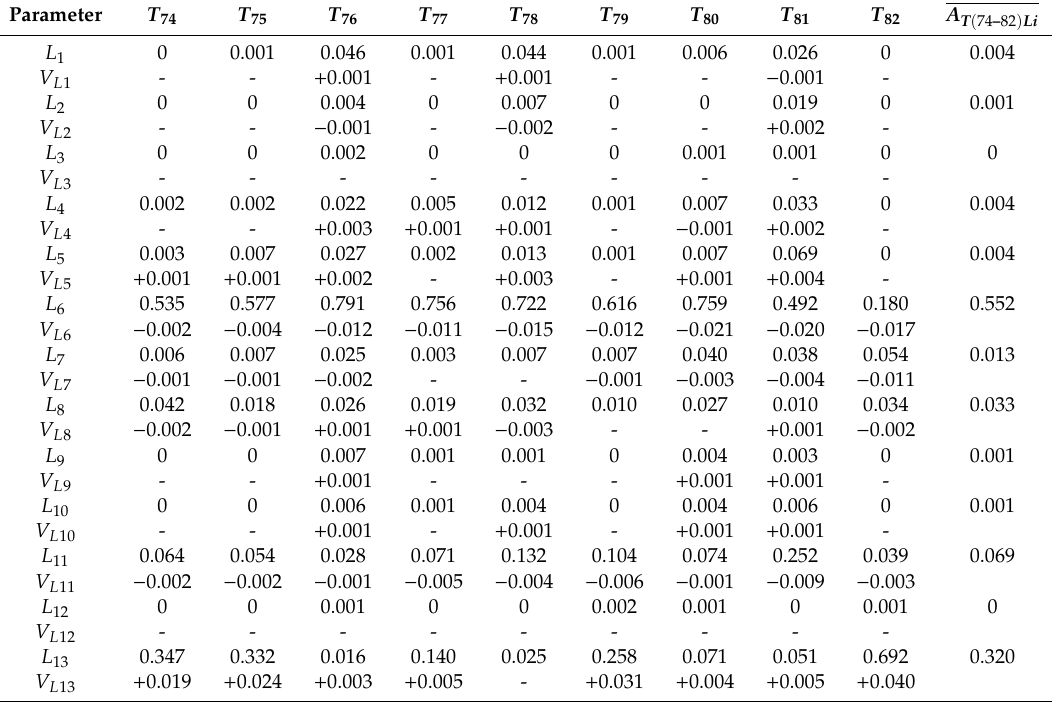
Table A16. Activity per land category in Russia, Far Eastern Federal District. Mean values for